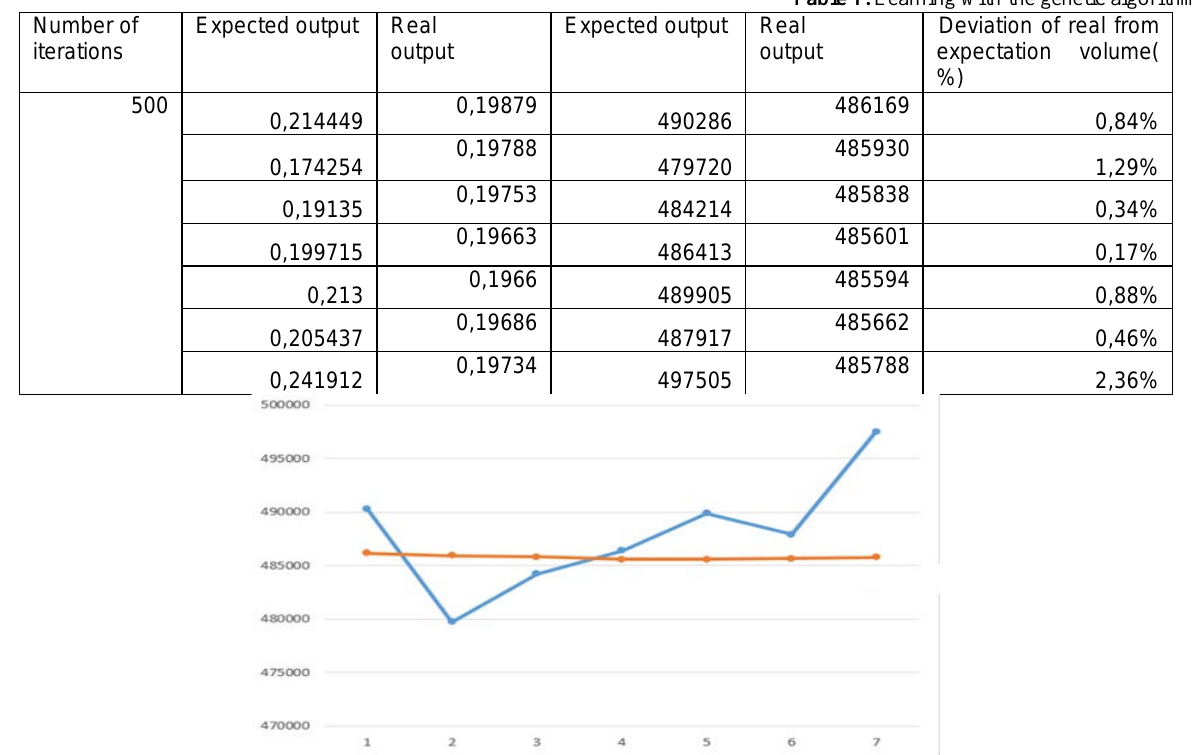
Fig. 5. Forecast power generation using ANN with GA as a learning algorithm. Table 2. Learning with the back propagation algorithm